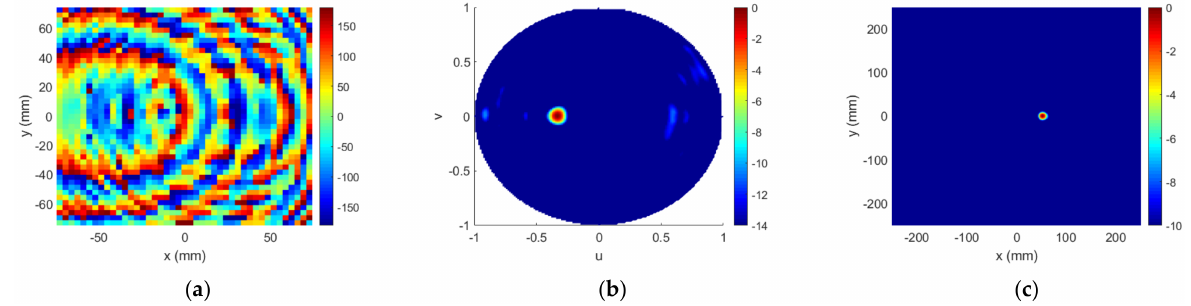
( ◦ ); ( b ) FF pattern RP (cid:48)(cid:48) ( u , v ) (dB); TA